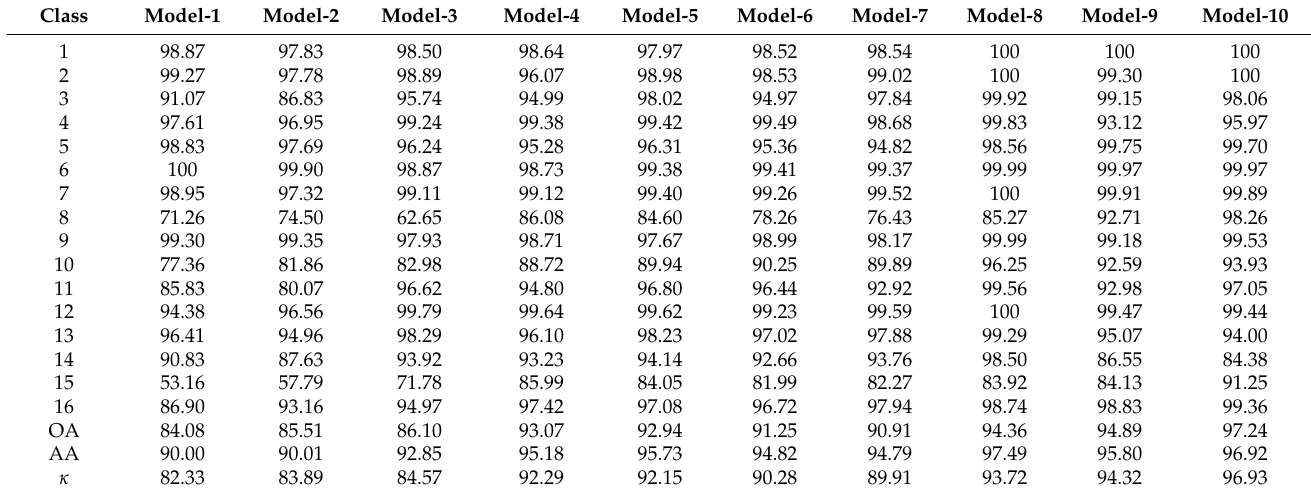
Table 6. Specific classification results of each model on the Salinas